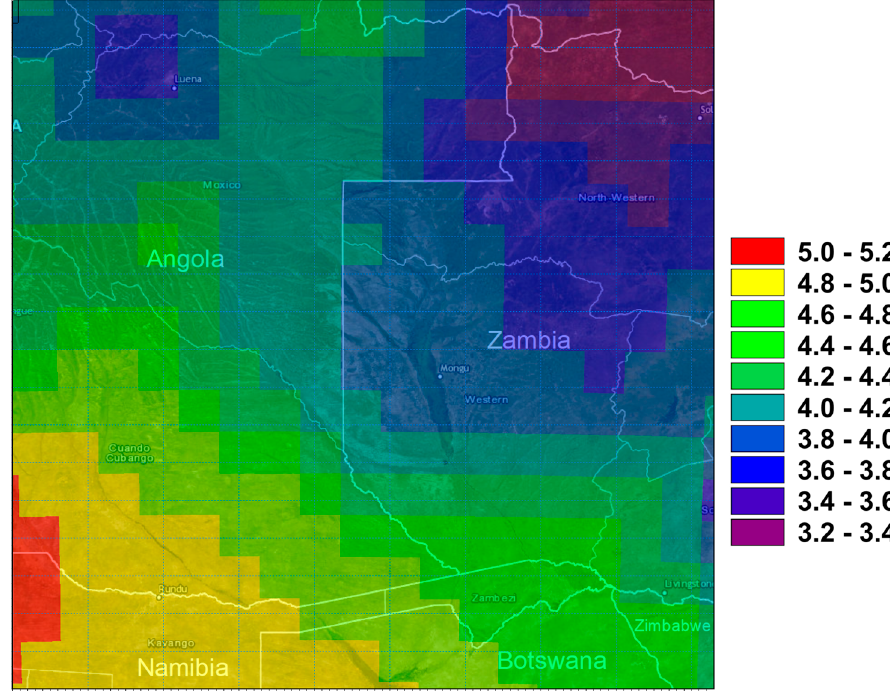
Figure 17. Screenshot of the MIKE-SHE average reference evapotranspiration (ET 0 ) (mm/day) input grid for the Upper Zambezi River Basin extracted using the Large Basin Data Portal based on climatic data from the Earth Science Research Laboratory (ESRL) datasets for the years 2009–2019.